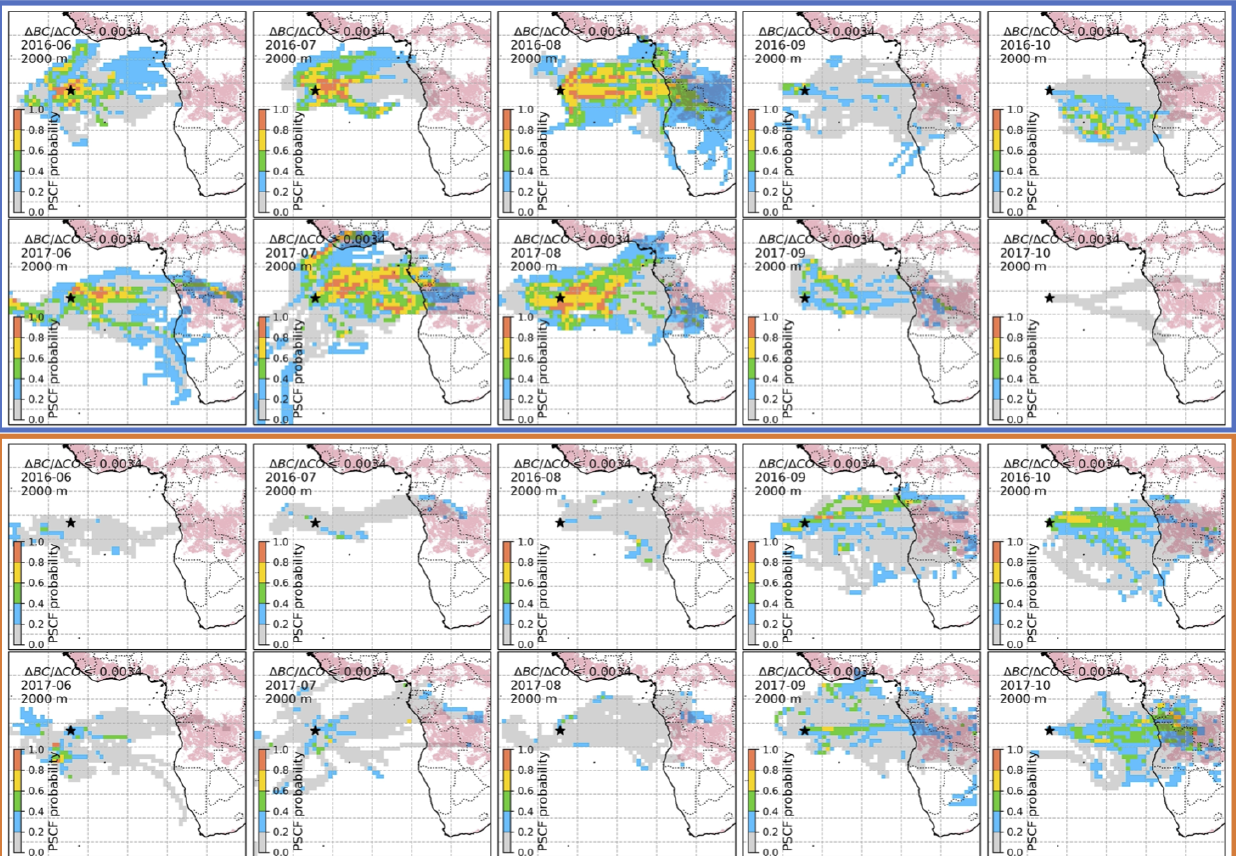
Figure 9. The spatial distribution of potential source contribution function (PSCF) during the African fire season in 2016 and 2017. The 7d backward trajectories in the upper blue and lower orange rectangles indicate air mass flow when BC /(cid:49) CO > or ≤ 0.0034, respectively. Different colours indicate the probability of different transport paths of the plumes. Note the trajectories are initiated at an altitude of 2000m at the sampling site (marked by black star) on ASI. The pink areas on the continent indicate savannah, the main burning material in each